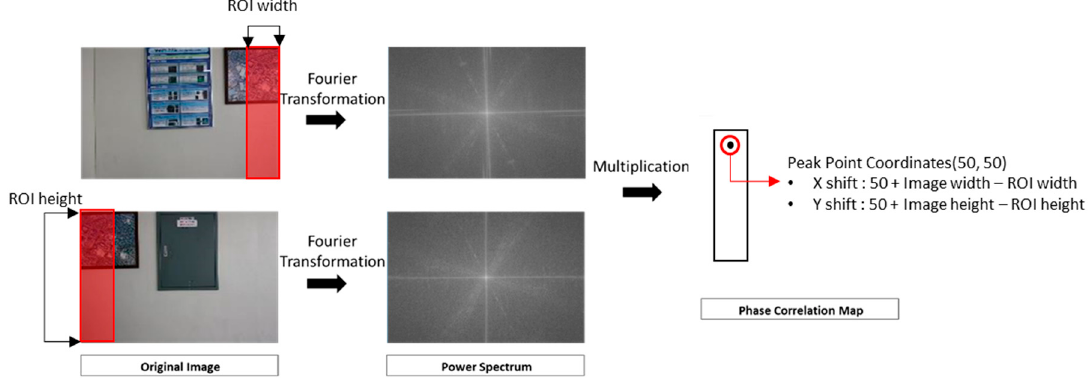
Figure 5. Process of Fourier transformation and phase correlation.